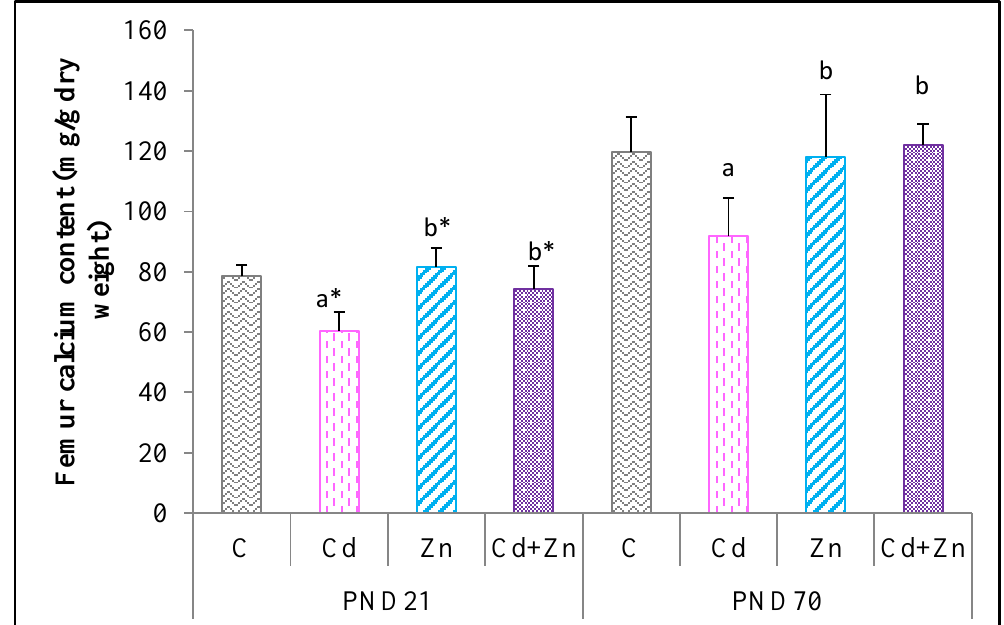
Figure 2. Femur calcium content of rat pups from control females and pups from females exposed to cadmium (50 mg / L Cd as CdCl2) and / or zinc (60 mg / L Zn as ZnCl2) during gestation and lactation. Means ± SEM from six samples in each groups; a* ( p < 0.01); a ( p < 0.05): significant di ff erence compared to the control group (C); b* ( p < 0.01); b ( p < 0.05): significant di ff erence compared to the Cd group (Cd).